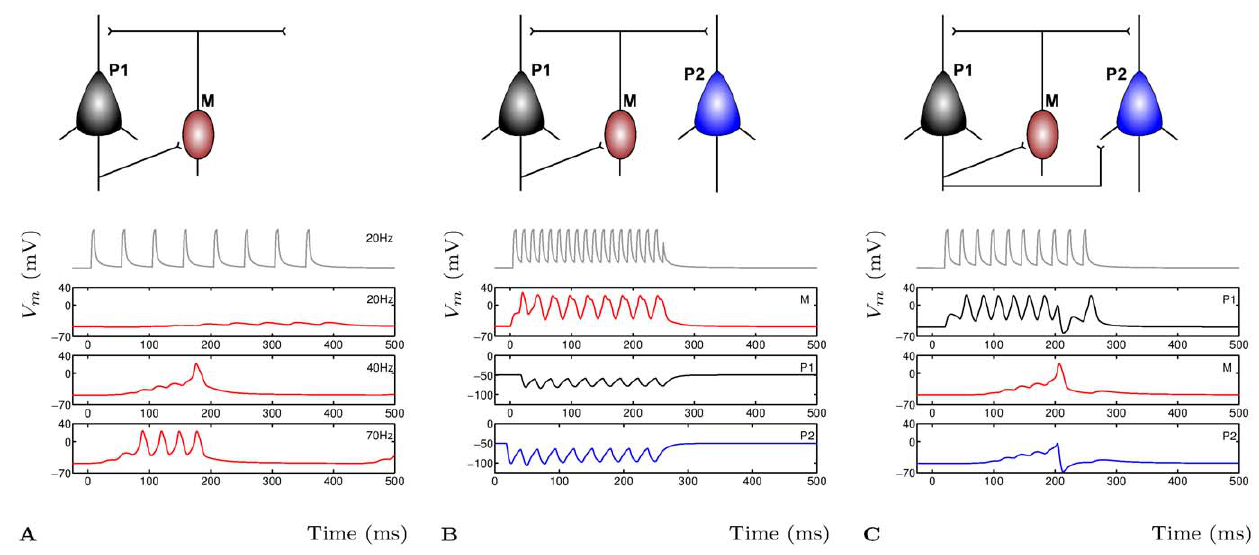
Figure 6. Short Term Plasticity in cortical layer 5 microcircuitry. A Short term facilitation of the pyramidal-Martinotti synapse, shown is the activity of the Martinotti cell when the pyramidal cell is stimulated at 20 Hz, 40 Hz and 70 Hz. B Two pyramidal and one Martinotti neuron with STF, the Martinotti neuron is stimulated at 70 Hz with adaptive post-synaptic IPSPs at neurons P 1 (black) and P 2 (blue). C Complete microcircuit with STF, except the P 1 to P 2 synapse with STD. P 1 is stimulated at 40 Hz which results in a single AP in M that terminates the stimulation burst in P 1 and causes a large IPSP in P 2 .